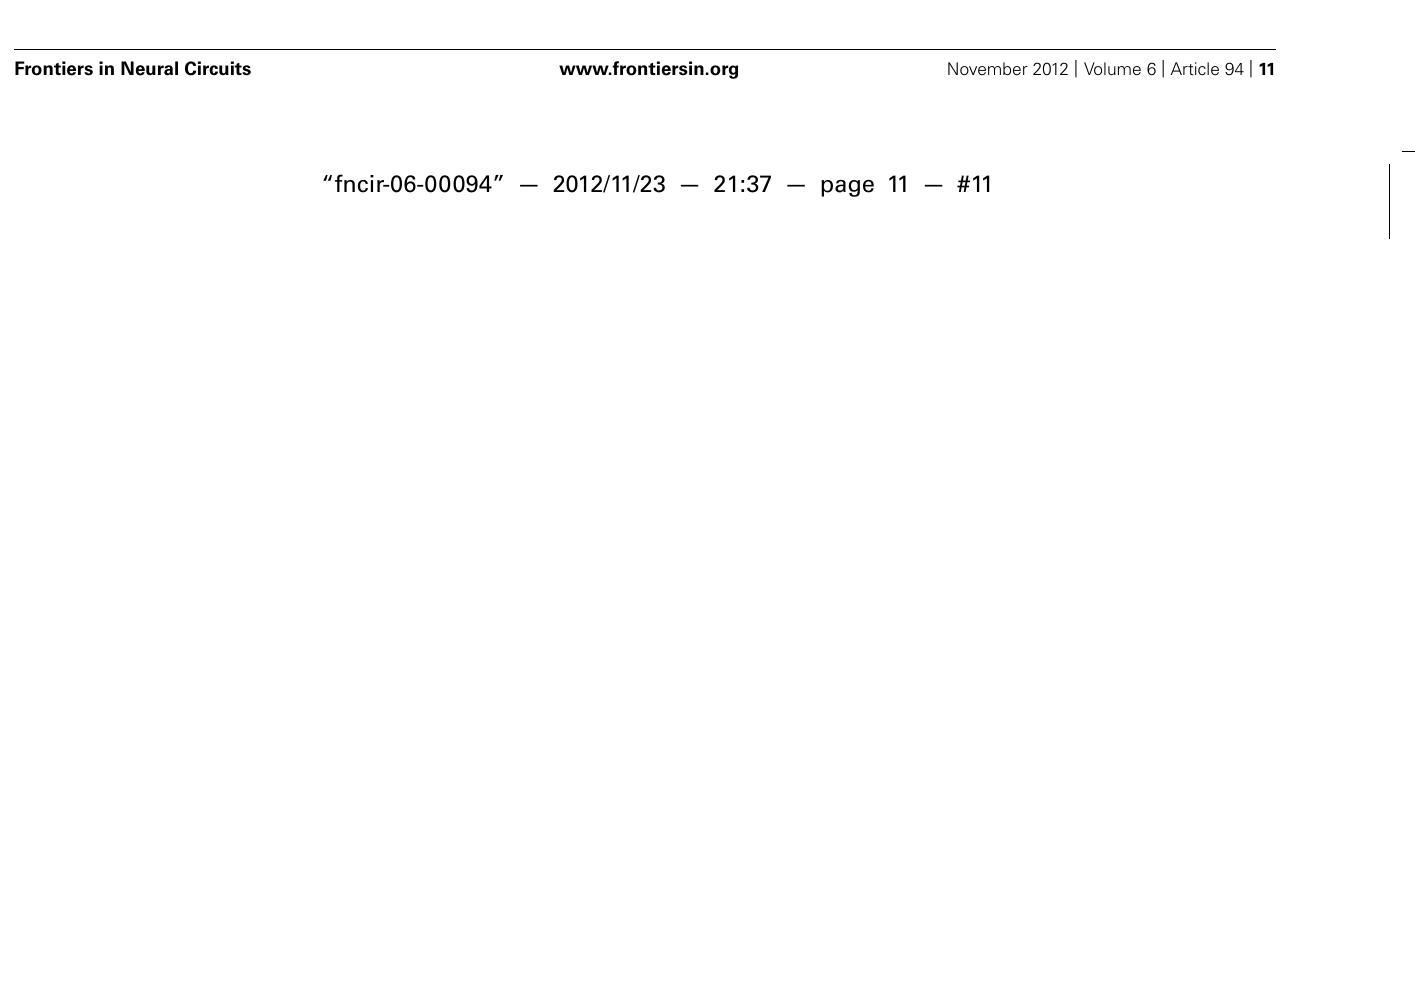
completely silence the network activity, 100 nM MDZ was needed, while the same effect was reached with 30 nM CLZ. Lower : Plots of number of engaged neurons (normalized with respect to control).These data were derived from four complete double-experiments in which both BDZs were applied successively after a short 3 h-wash-out, and results were normalized and averaged for each plot ( n =